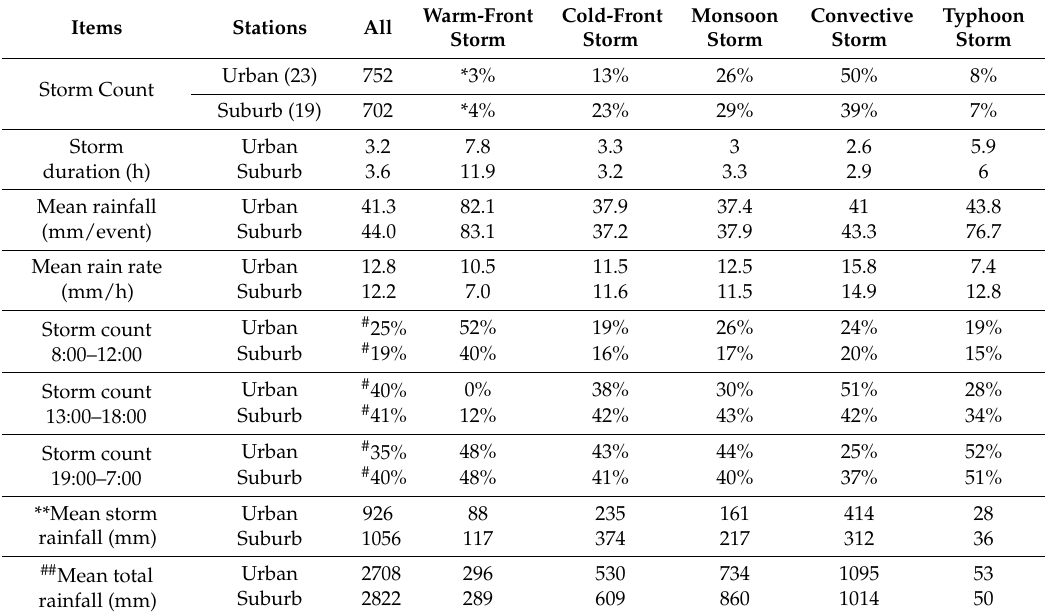
Table 3. Statistics of the storms at the 42 weather stations from July 2015 to October